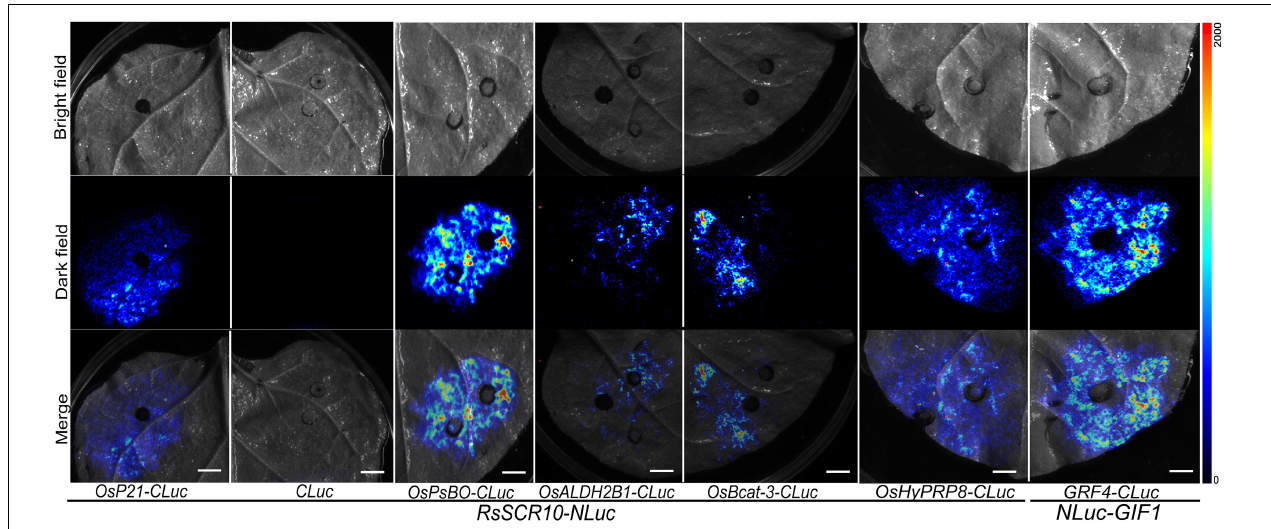
FIGURE 9 | Luciferase complementation assays for RsSCR10 with five rice proteins. The LCA assay in tobacco leaf epidermis cells. NLuc-GIF1 and GRF4-CLuc are positive controls (He et al., 2021). NLuc-RsSCR10 and CLuc are the negative controls. All experiments were repeated at least three